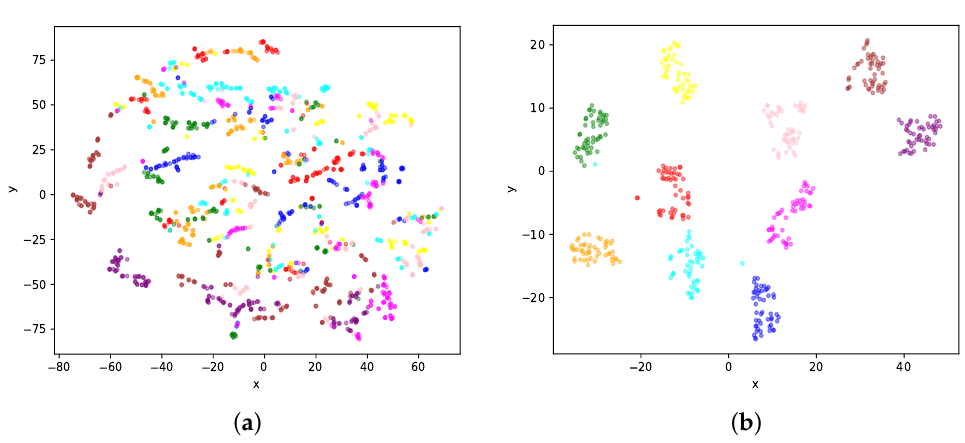
Figure 5. Visualization of classification results of FEF-Net. Points with the same color belong to the same target class. ( a ) Input multiview samples and ( b ) corresponding output.